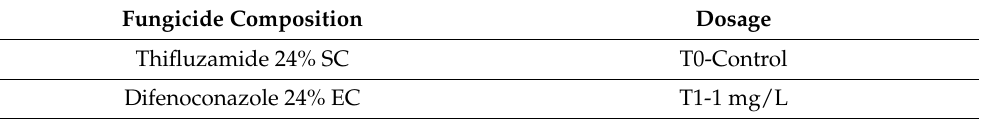
Table 2. Fungicide composition and dosage of test item solution. Fungicide